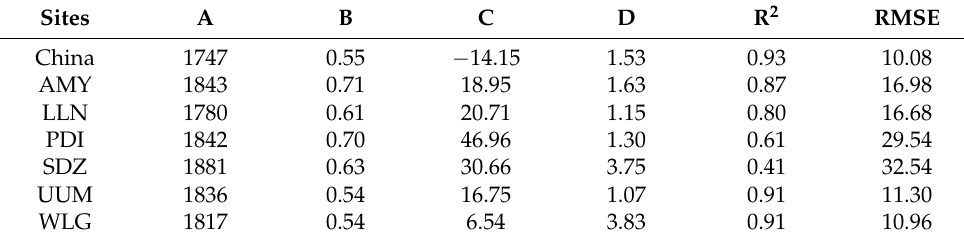
Figure 4. Linear sinusoidal trend model fitting results of the monthly mean XCH 4 concentrations over China from January 2003 to December 2021. Table 3. Comparison of the linear sinusoidal trend mode parameters for China and the ground